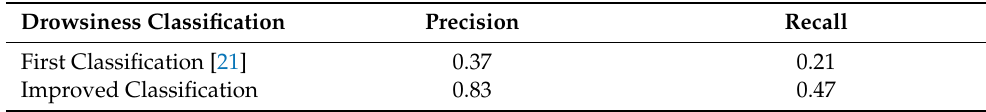
Table 5. Precision and Recall